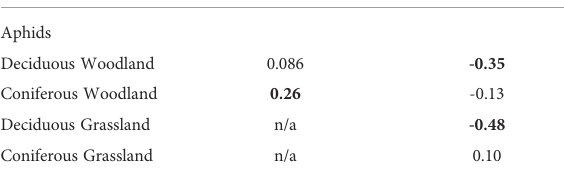
TABLE 3 Signi fi cance of Spearman correlations for coccinellid abundance with aphids recorded from trees at different site types. Associated